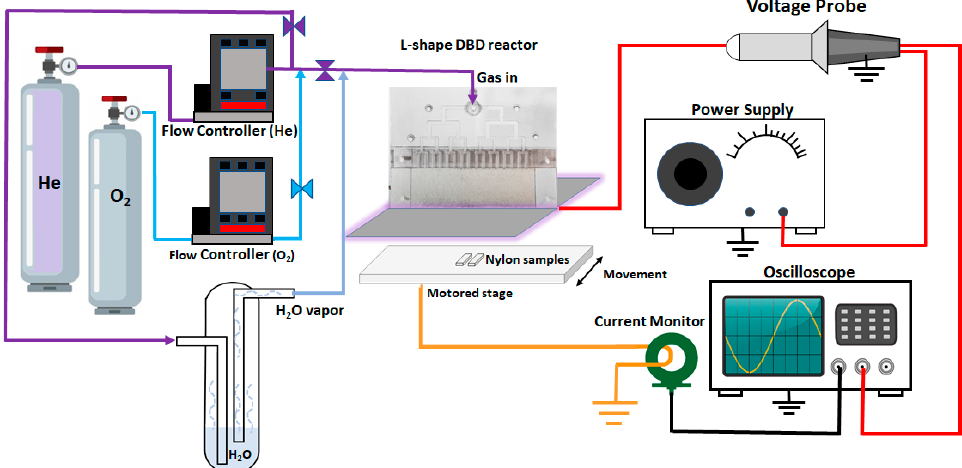
Figure 1. Schematic diagram showing the plasma setup, including the apparatus connected to the L-shape DBD plasma reactor.